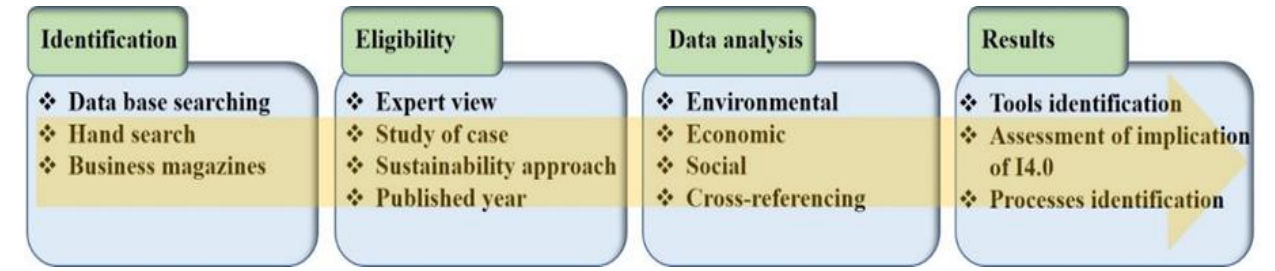
Figure 2. Step of the implemented Research methodology.